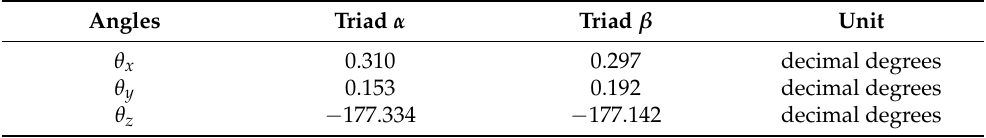
Table 3. Euler angle values that defined the matrices C b force measurements needed to determine these values were acquired for N = 31 tilted positions